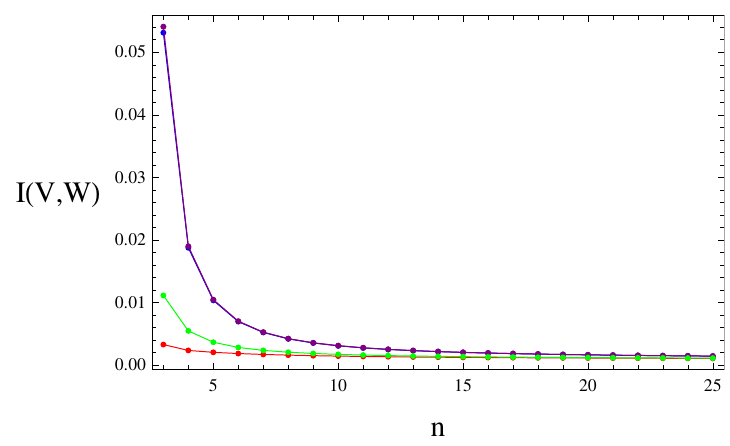
Figure 20 . The mutual information of gauge (cid:12)elds with Coulomb gauge between two square regions of size n and separation distance n for four di(cid:11)erent algebra choices, from top to bottom A and ^ A (purple curve), A ^ A (red curve) and A (cid:25) center (green curve). There are two curves in the purple curve. One is mutual information of algebra A and the other is of algebra ^ A . At n = 3, the mutual information of algebra A is a little larger than algebra ^ A . For other values of n , they are hard to